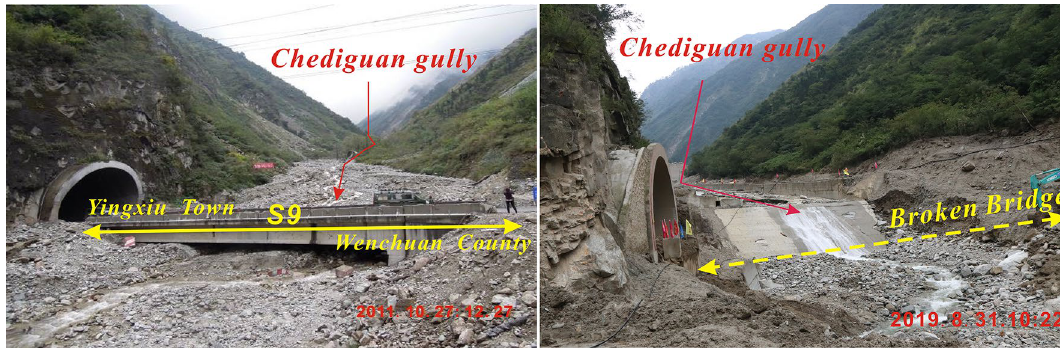
Figure 1. Gully mouth photos of Chediguan gully after the debris flow in 2011 and